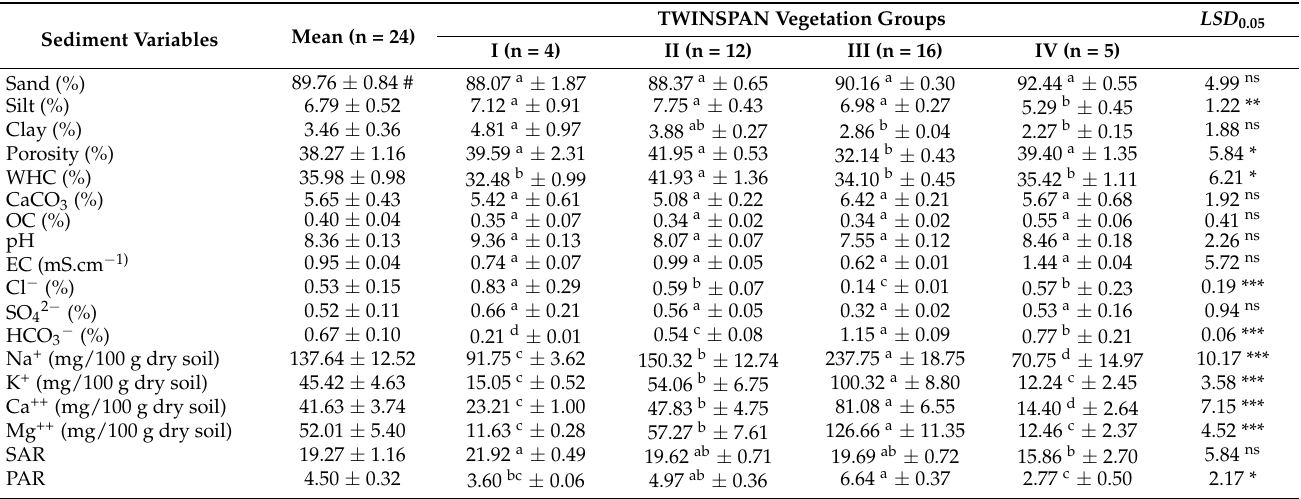
Table 3. Soil physical and chemical analysis of the four identified vegetation groups (I–IV) of the study